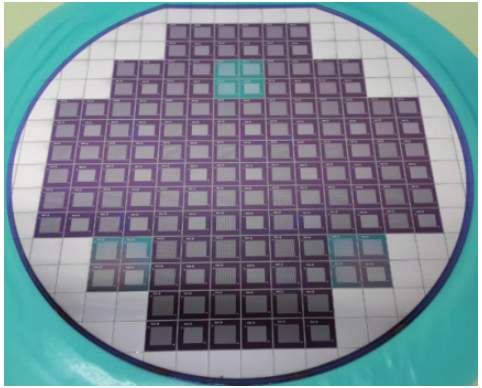
Figure 3. Final fabricated transducers on the 6 inch silicon wafer.